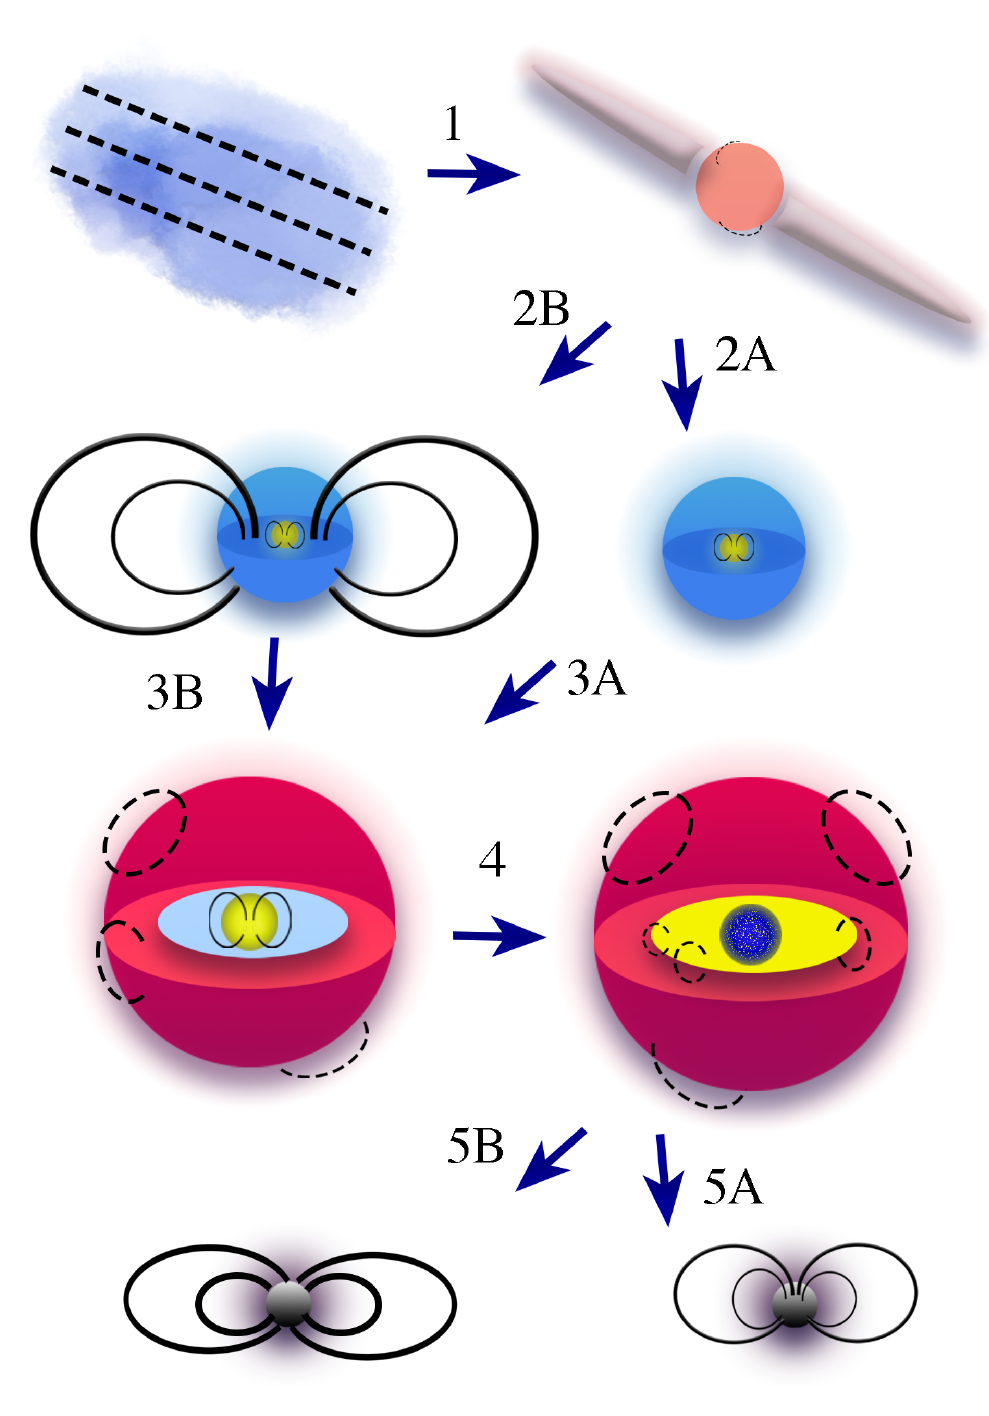
Figure 4. Simplified phenomenological picture of magnetic field evolution from early to late stages of stellar evolution for a typical high-mass star. The objects are not to scale. The time evolution proceeds from the molecular cloud phase towards the compact remnants. The black lines indicate magnetic field lines. For stars: Convective burning regions are shown in yellow. Convective non- burning regions are shown in red. Radiative regions are shown in blue. The distinct structure of the pre-supernova Red Supergiant is greatly simplified. See text for the description of the phases, labelled from 1 to